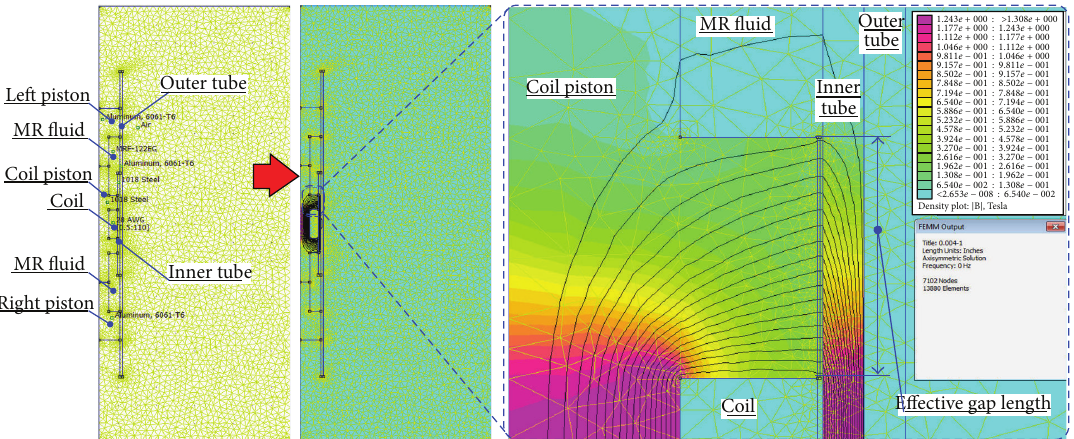
Figure 7: Magnetic field analysis of the prototype